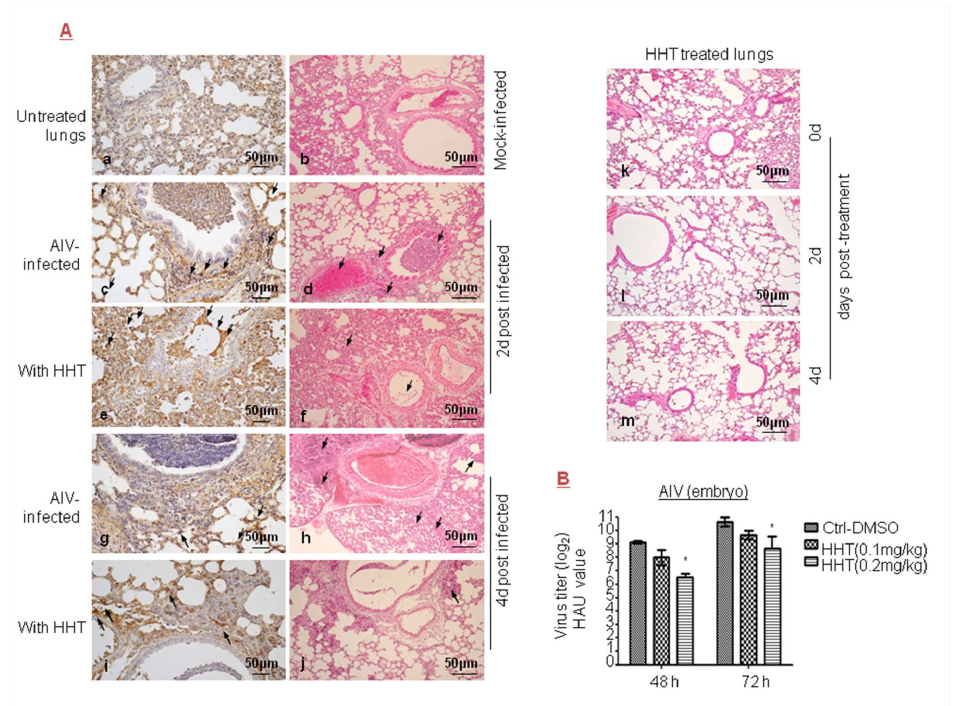
Figure 4. Inhibitory effect of HHT on avian influenza virus (AIV) infections. ( A ) Antiviral activity of HHT against AIV. Six- to eight-week-old BALB/c mice were mock infected ( a , b ) or intranasally (i.n.) injected with 10 6 PFU of AIV, while being intraperitoneally (i.p.) injected with 0.8 mg/kg/day HHT ( e , f , i , j ) or PBS containing 1% DMSO ( c , d , g , h ) in 100 µ L volume for two sequential days. Representative lung sections from each group were subjected to immunohistochemical analysis with antibody against AIV-NP (left) and hematoxylin and eosin (H&E) staining (right) at two or four days post infection. HHT at days 0, 2, and 4 after treatment ( k , l , m ). Arrows in right panel indicate inflammatory cell infiltration, erythrocyte infiltration, and drop in mucous epithelium in bronchia ( A ). SPF chicken egg was challenged with AIV inoculation of 500 PFU, and simultaneously treated with 0.1 or 0.2 mg/kg HHT or PBS containing 1% DMSO. The eggs were incubated for 48 and 72 h and analyzed at the